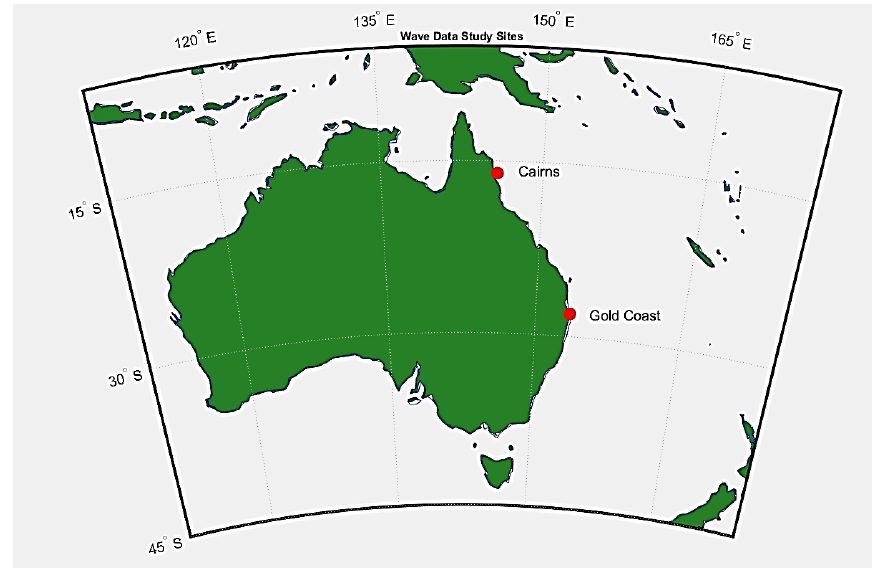
Figure 1. Study site locations across coastal areas of Queensland, Australia.